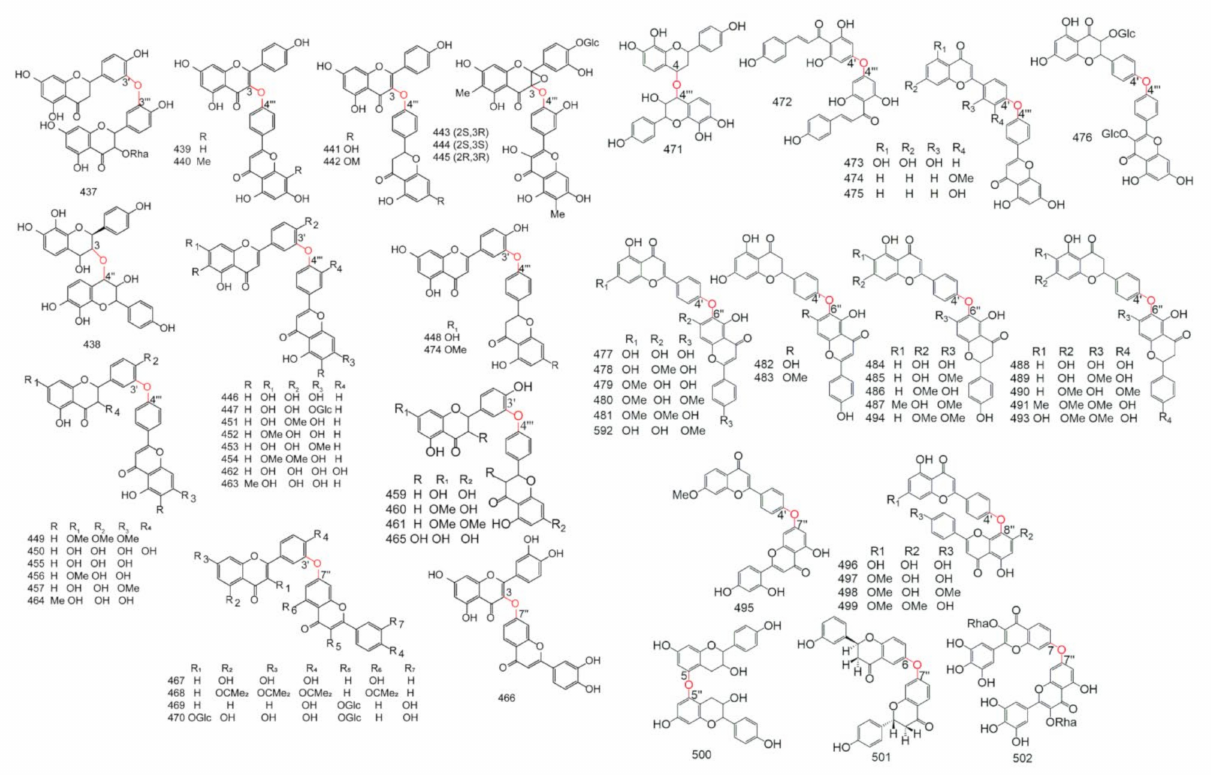
Figure 9. The structure of C- O -C type biflavonoids.